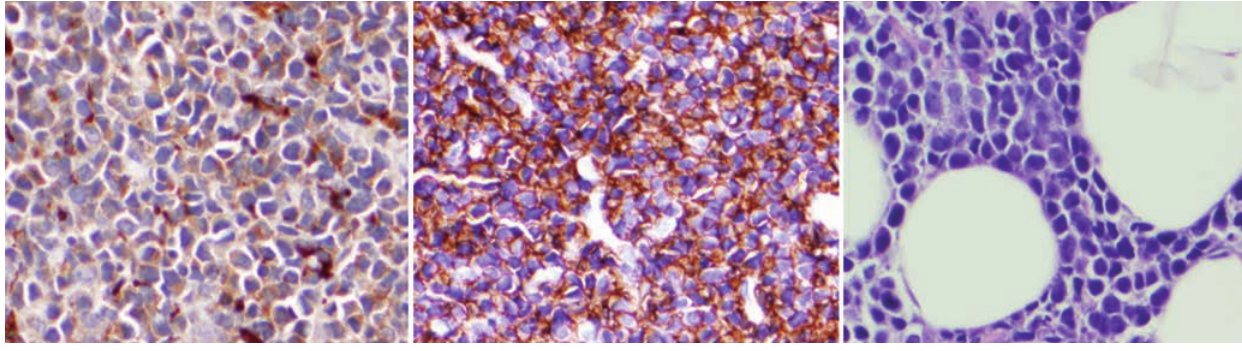
Figure 1. Representative images of omental tissue sections stained for CD43 (left panel), CD68 (middle panel), and high power Hematoxylin & Eosin showing tumor infiltrating fat (right